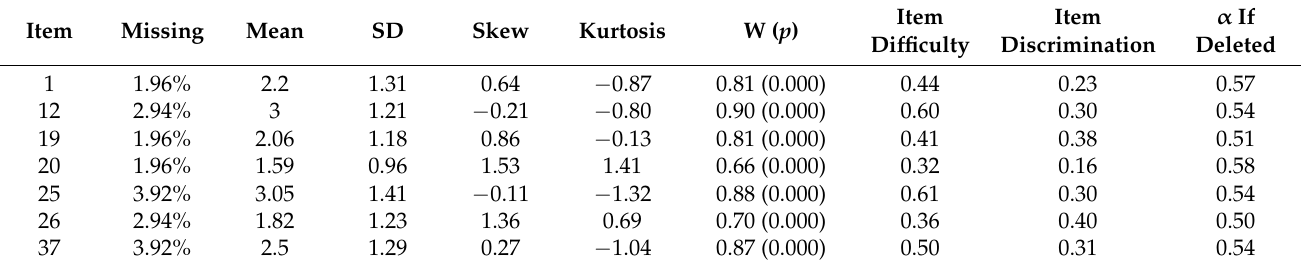
Table 6. The concept of emotions related to oral health.